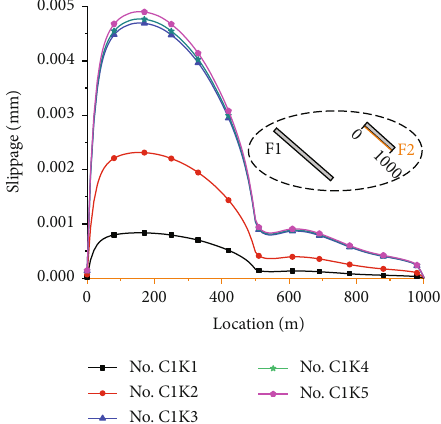
Figure 16: The fault slippage of F2 according to di ff erent permeability (Nos.